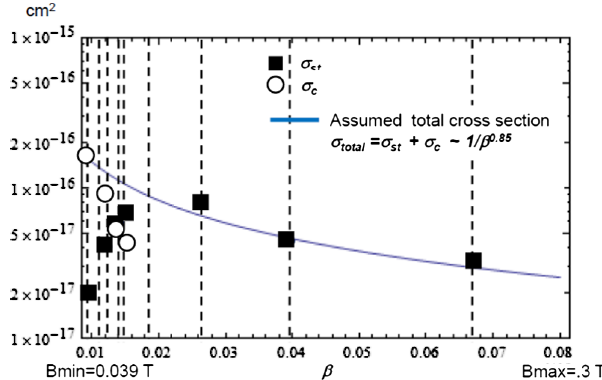
FIG. 8 (color online). Electron capture and loss cross sections of light ion with A=Q ¼ 4 in Ref. [14] (in N 2 ) and Ref. [15] (in air), where σ C and σ are the electron capture and electron st stripping cross section, respectively.